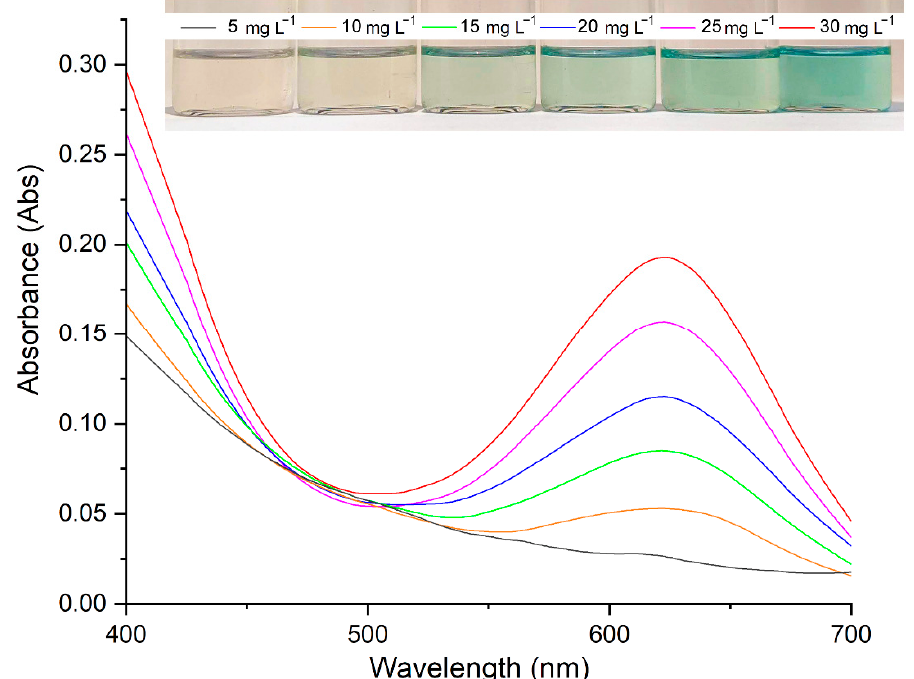
Figure 5. UV–Vis spectra of the colored product obtained from the reaction of Cr(CO) 6 with 2AP at different concentrations.